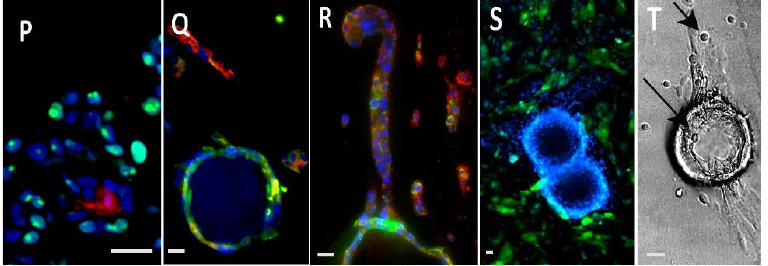
Figure 3. Human mammary epithelial cells (MCF10A) express partly differentiated structures in our composite organoid model. ( A )—Cells were grown in suspension on Cytodex beads. ( B )—When embedded in a collagen/BME hydrogel, they initiated organized tubule-like structures. ( C )—These structures gave rise to globular buds. ( D )—Some cells migrated as individual cells or cords, among the bigger tubule-like processes. ( E )—Other gel compositions, such as a hyaluronate/gelatin hydrogel, induced less active migration, but allowed organized morphogenesis and formation of organized buds stable after a one-month culture. ( F , G )—Cells formed overlapping layers at the surface of the beads (CK5, green). ( H )—A subpopulation of luminal cells (CK8, green) could be seen, migrating as individualized cells. ( I – M )—Cell polarization was demonstrated by the basal localization of α 6 integrin (green) and the luminal localization of mucin 1 (red). It should be noted that the same cells coexpress α 6 integrin and mucin 1. ( N )—Desmosome expression is attested by the cell edge punctuated localization of desmogleins (green). ( O )—Cohesive cell buds express E-cadherin at cell edges (green). ( P )—Bud cells expressed PCNA1 (green), suggesting active proliferation and a low level of apoptosis, always inside cell buds (caspase 3, red). ( Q , R )—MCF10A cells adhering to the microsupports expressed CK5 (green), but lost it to CK8 (red) in cell chords migrating away from the beads. ( S )—Introducing GFP-labeled fibroblasts induced narrow cell–cell interactions. ( T )— Introducing immune NK cells (NK92) resulted in invasive migration and epithelial cell binding by NK cells (arrows). Most immunofluorescence panels included Hoechst dye to visualize nuclei. Scale bar: 10 µ m.